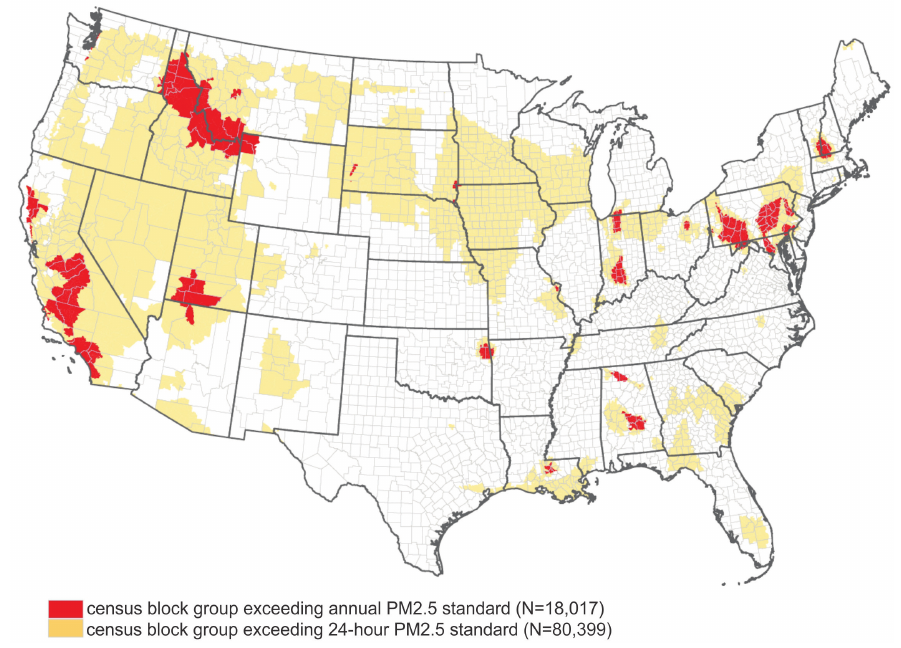
Figure 7. Geographic distribution of census block groups in the contiguous United States that exceeded the PM 2.5 air quality standards in